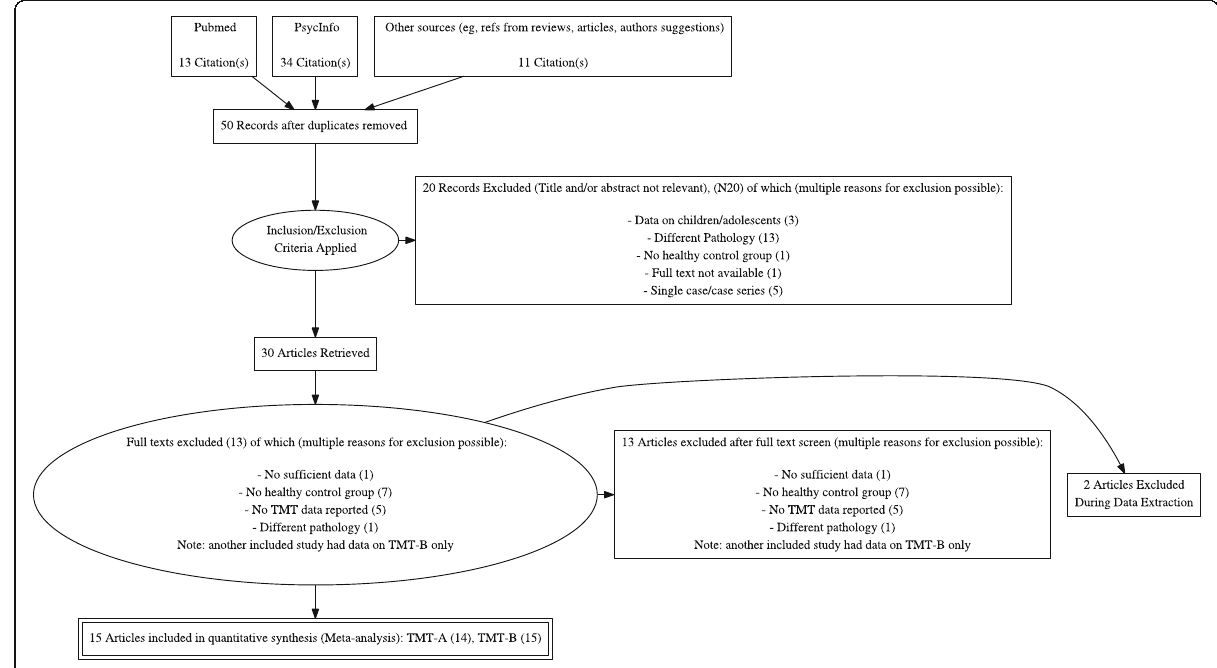
Fig. 1 PRISMA Flow Diagram of the studied screened, assessed for eligibility and included in the